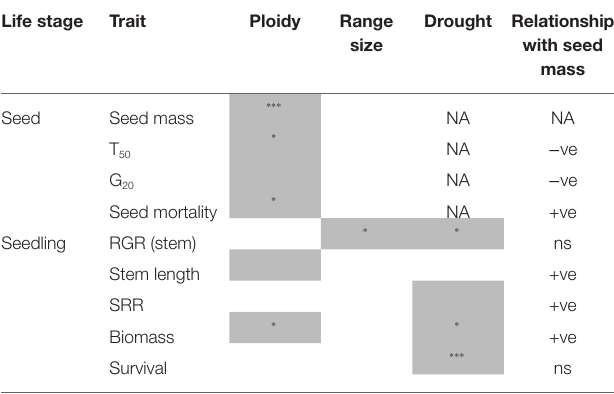
TABLE 2 | Summary of results for all traits and factors